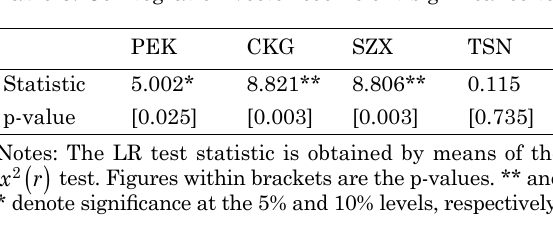
Table 8. Cointegration vector coefficient significance